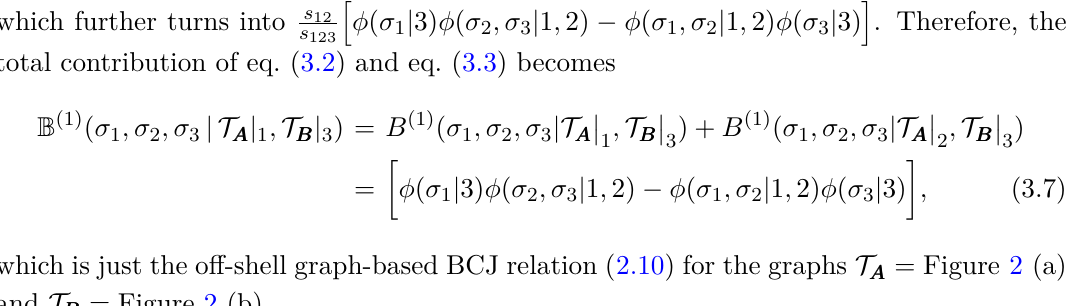
can be decomposed into AAA